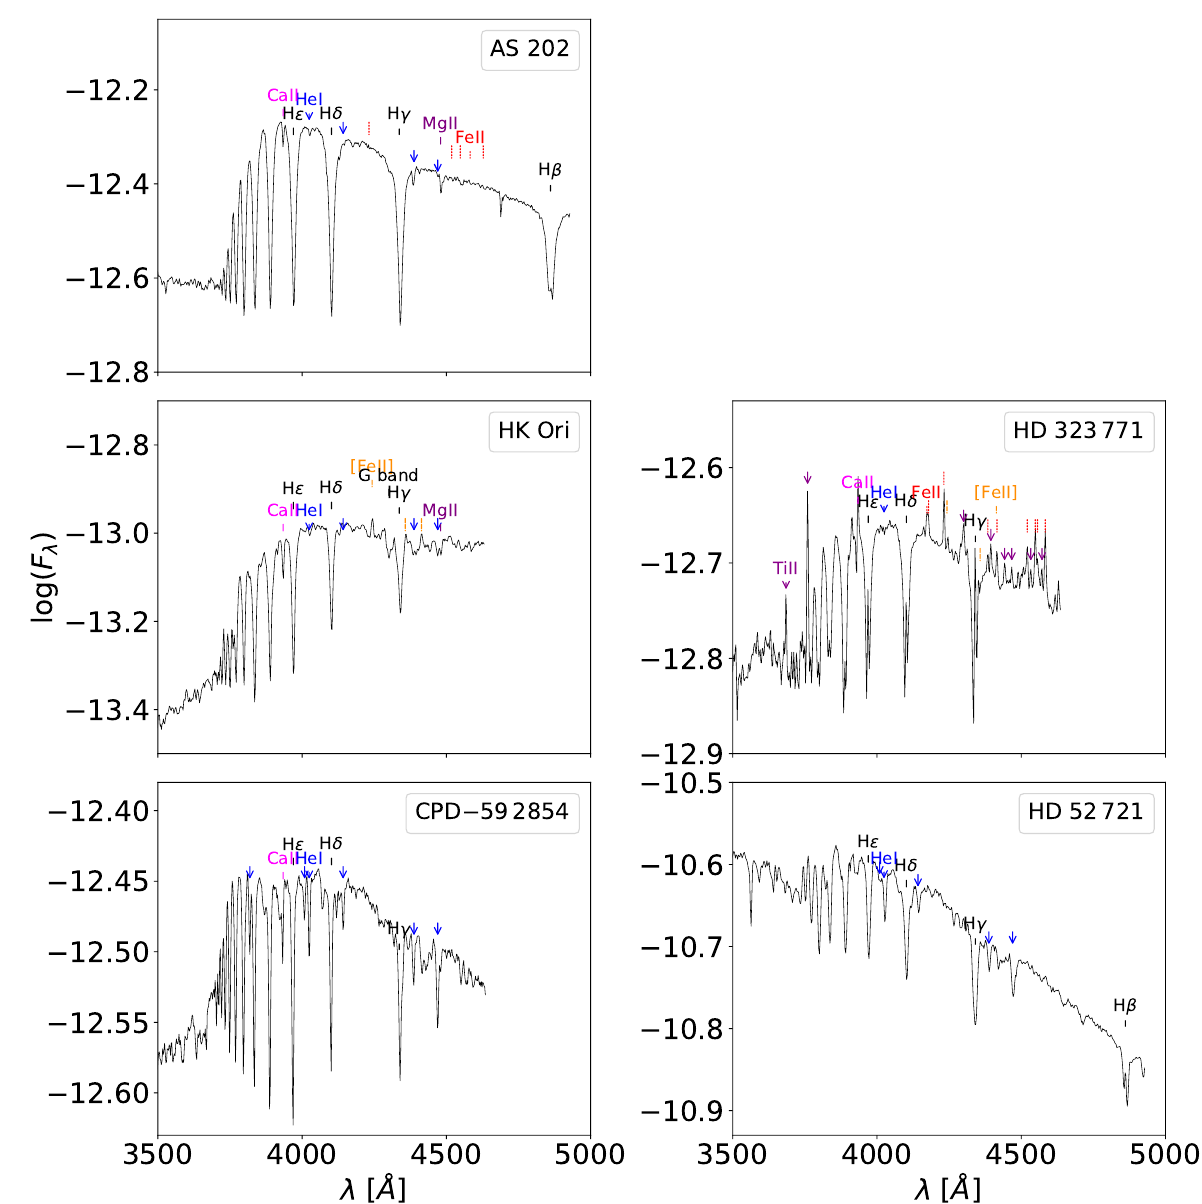
Figure 13. Examples of the energy distributions of B[e] stars without a second component of the BD in which some spectral line identifications are shown. The spectra were observed at CASLEO, Argentina. Figure adapted from Aidelman et al.